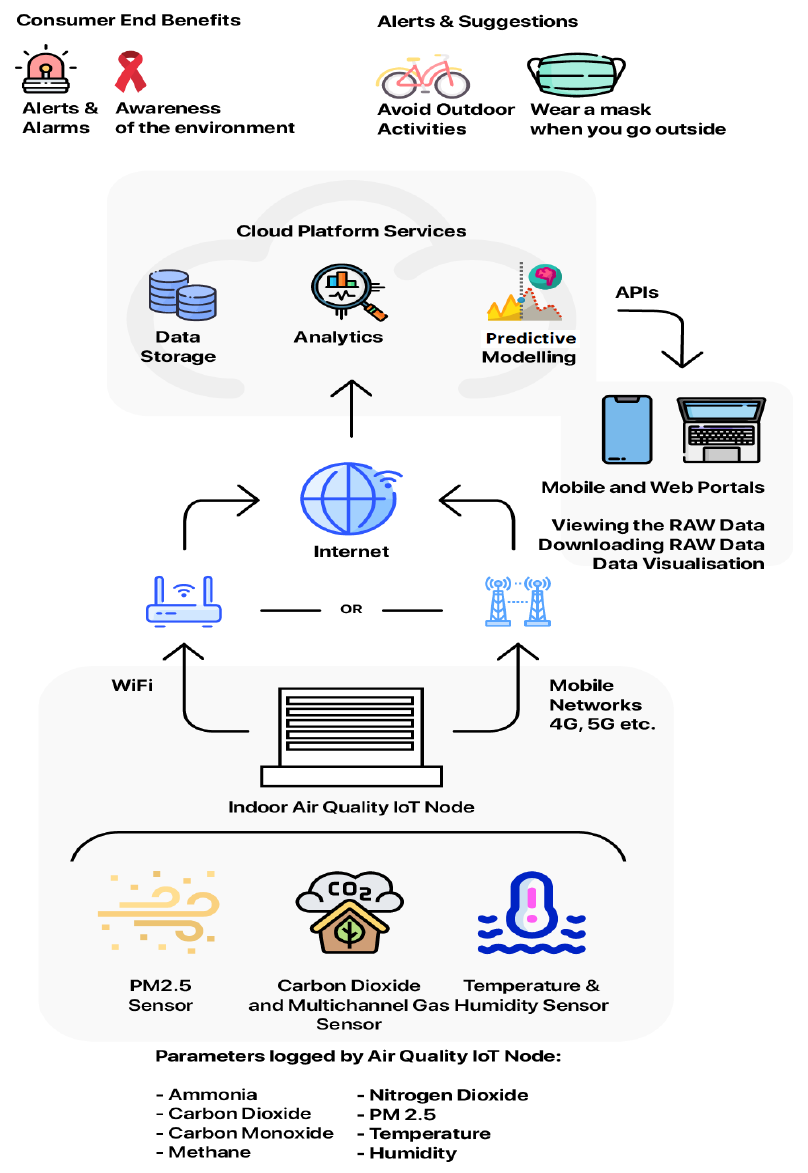
Figure 2. Architecture of the Proposed